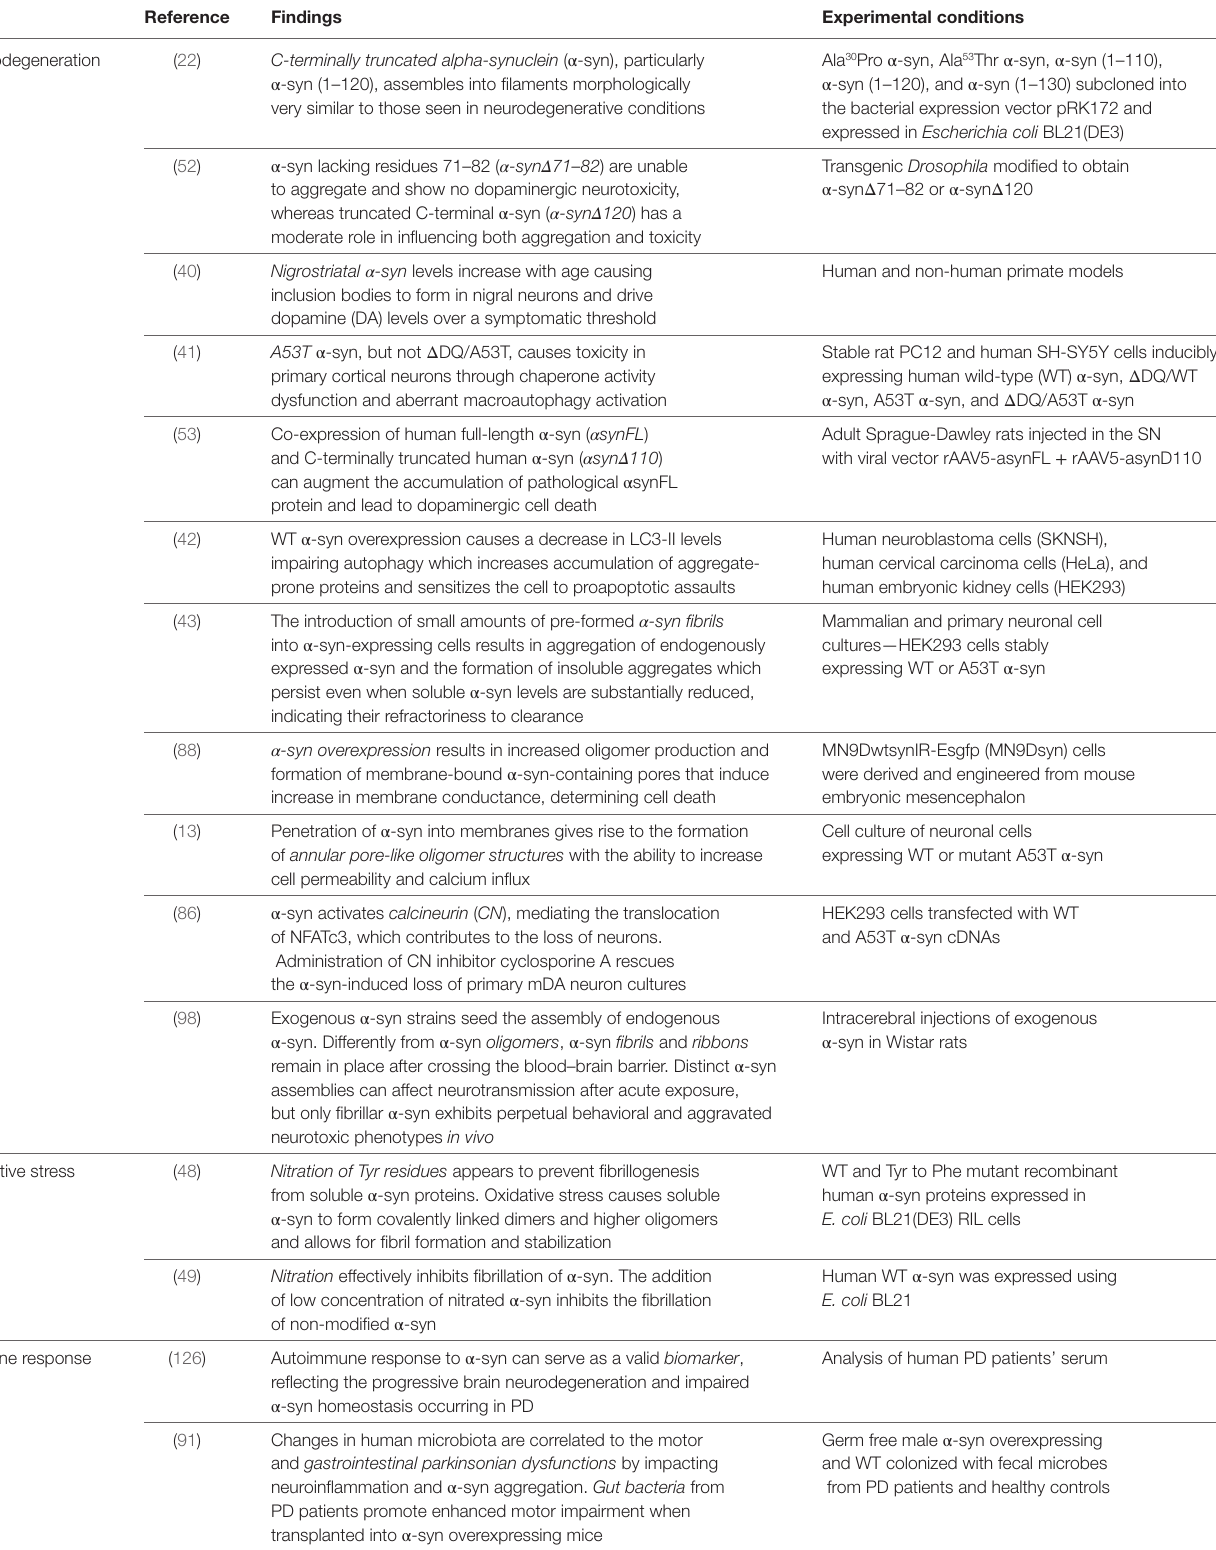
TABLe 1 | Summary of the findings on the role of α -syn in the distinct aspects contributing to pathogenesis of Parkinson’s disease (PD).